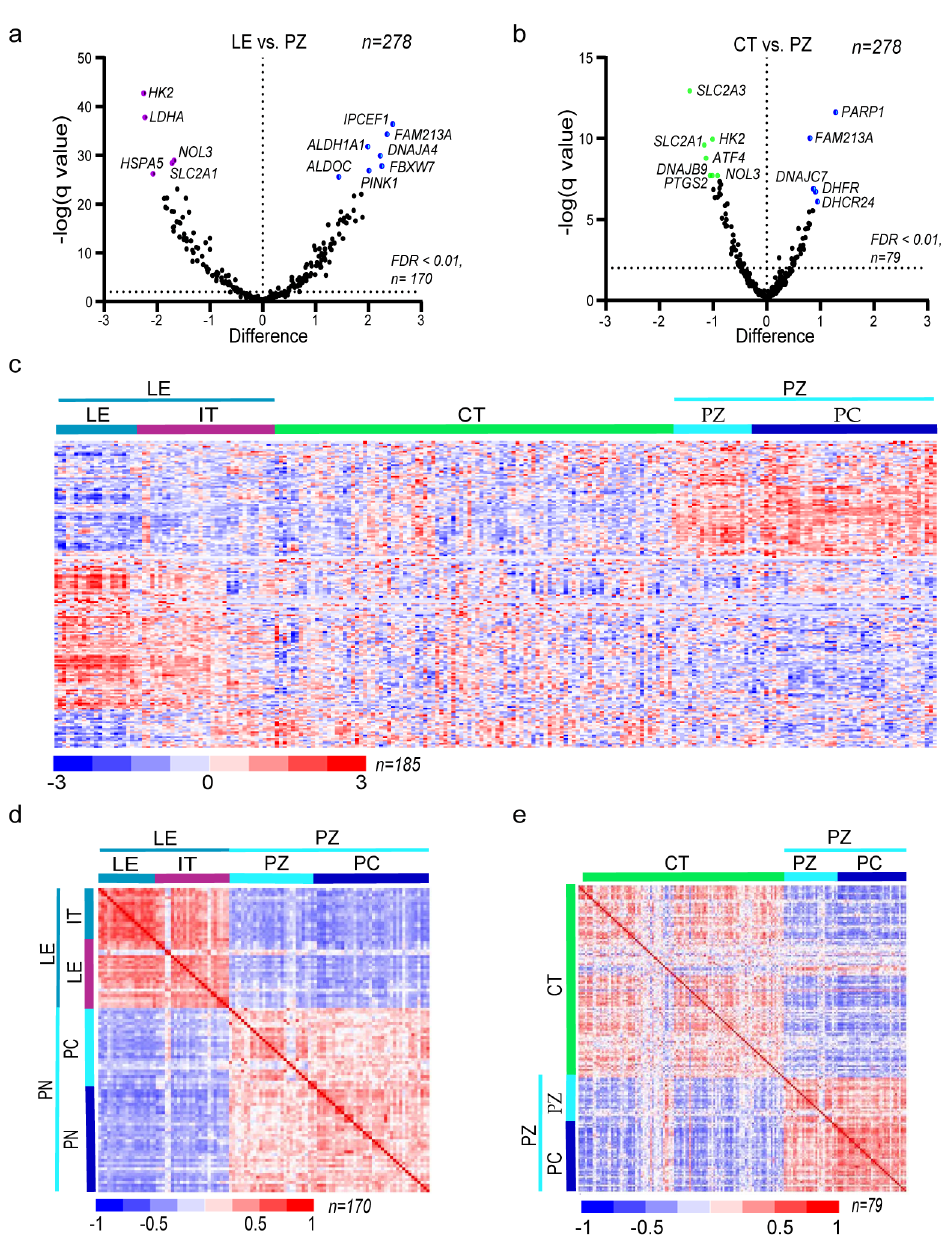
Figure 2. Oxidative stress-related gene expression patterns di ff er between anatomic features of glioblastoma: ( a , b ) volcano plots representing di ff erentially expressed genes between LE vs. PZ (pink—genes downregulated, blue—upregulated in LE) ( a ), and CT vs. PZ (green—genes downregulated and, blue—upregulated in CT) ( b ) , each dot corresponds to one gene ( n = 278), the horizontal dotted line shows a cuto ff for FDR < 0.01; ( c ) hierarchical clustering of 185 genes found as statistically di ff erentially expressed between LE, CT vs. PZ in all anatomic features of glioblastoma; rows and columns represent genes and samples, respectively. Colors correspond to the expression level of detected genes, and the blue–red scale bar indicates expression level, with blue being the lowest and red the highest; ( d , e ) a correlation matrix showing correlation coe ffi cients between gene expression in LE vs. PZ ( n = 170; Pearson r = − 0.407) ( d ), and CT vs. PZ ( n = 79; Pearson r = − 0.09) ( e ); blue–red bar scale indicates correlation coe ffi cients level, with blue being the negative and red positive